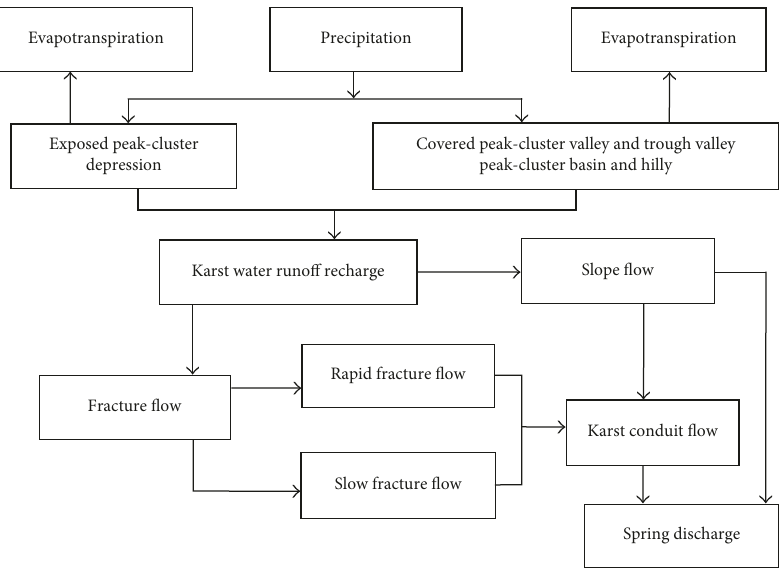
Figure 3: The karst runoff process of Houzhai kasrt basin.